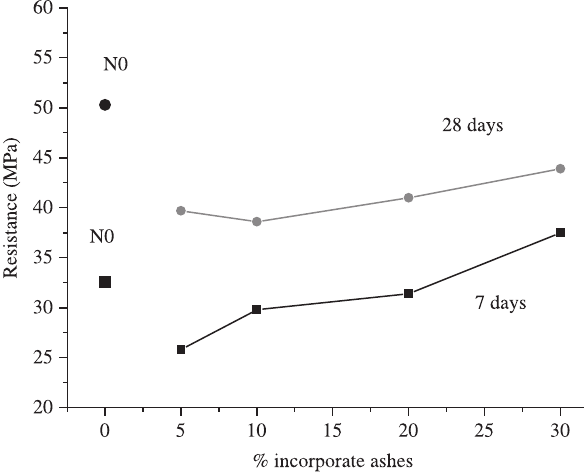
Figure 5. Compression resistance of the samples after different hydration times